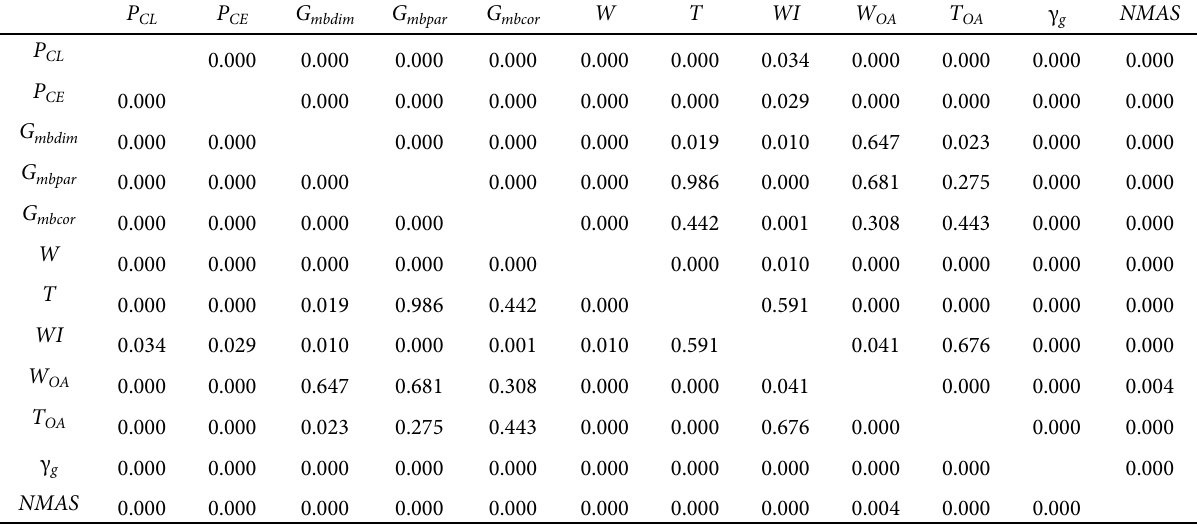
Table 4. Correlation significance (all the